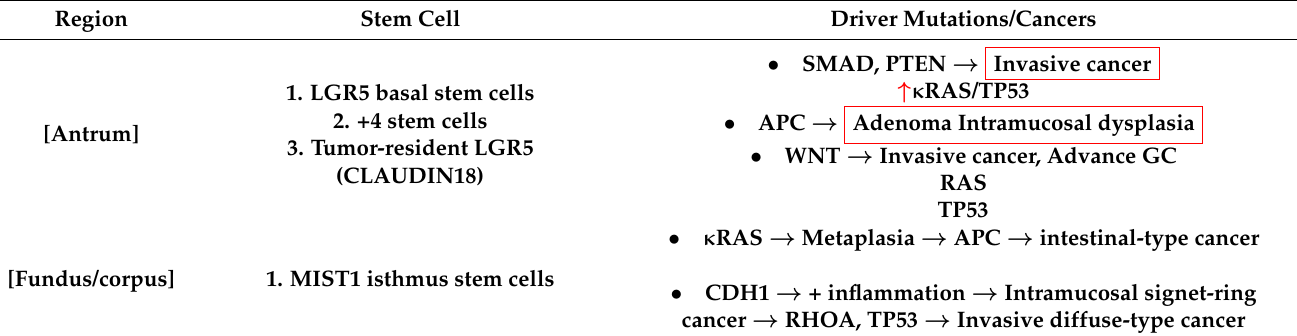
Table 1. Gastric cancer stem cells and iPS derived gastric cancer stem cells. Region Stem Cell Driver Mutations/Cancers